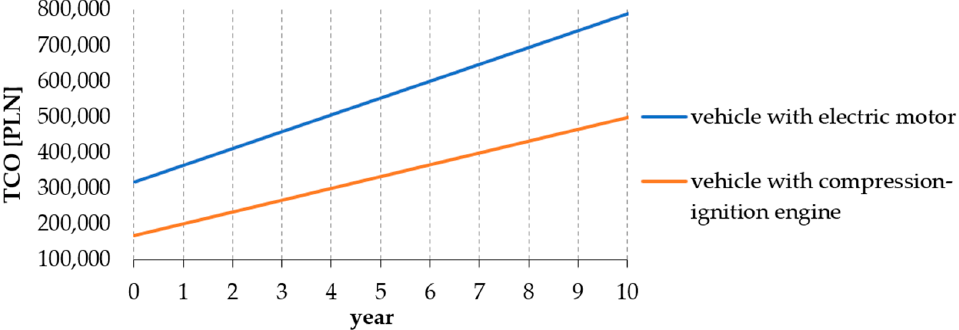
Figure 19. Total cost of ownership of vehicle during the whole operating period—electric vehicle is recharged only at public DC charging stations (the lowest price for 1 kWh was included in the calculations—Scenario A4).